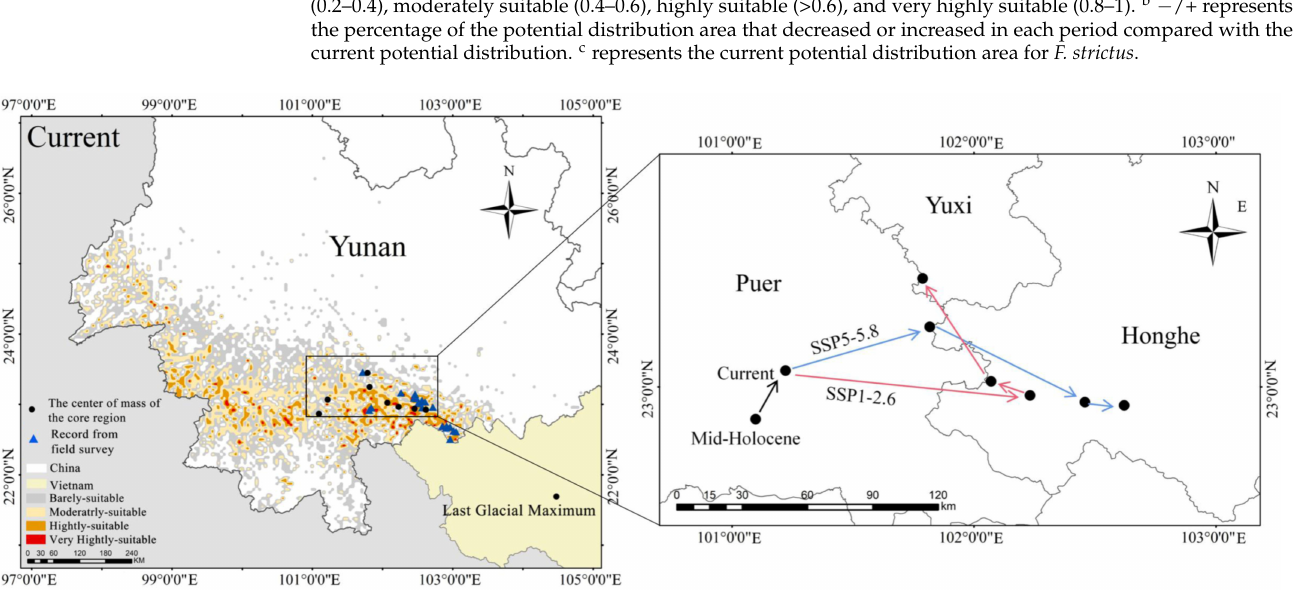
Figure 7. Spatial variation patterns of the potential geographical distribution for F. strictus in different periods. Pca is the priority conservation area for F. strictus